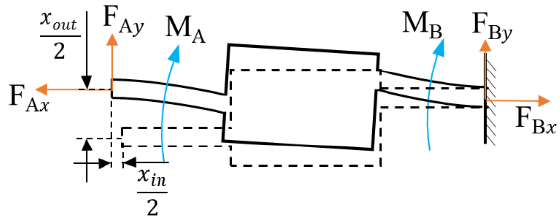
Figure 2. Force analysis of a flexible beam.